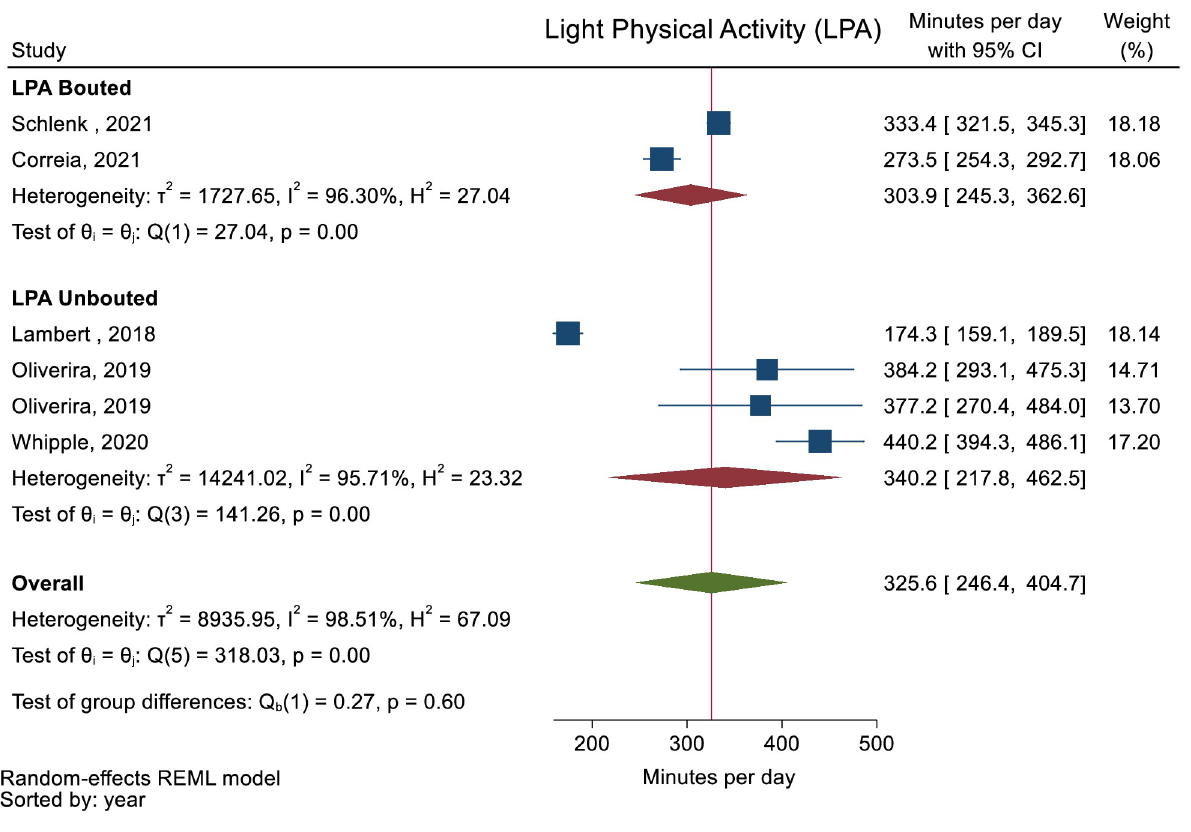
Fig 3. Forest plot showing daily minutes of Light Physical Activity (LPA) in people with multimorbidity.